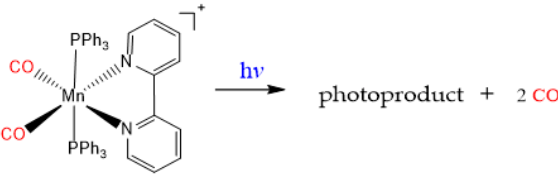
Figure 23. NIR-responsive amphiphilic polymer conjugates